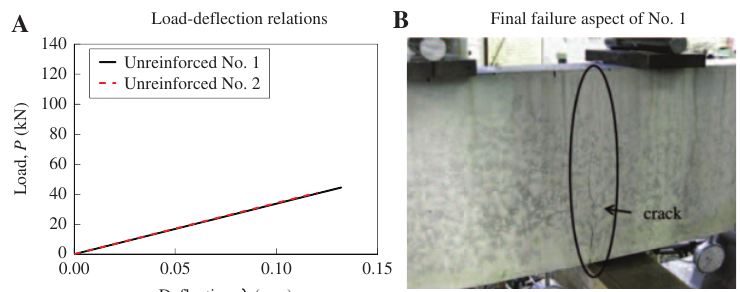
Figure 3 Unreinforced concrete beams.